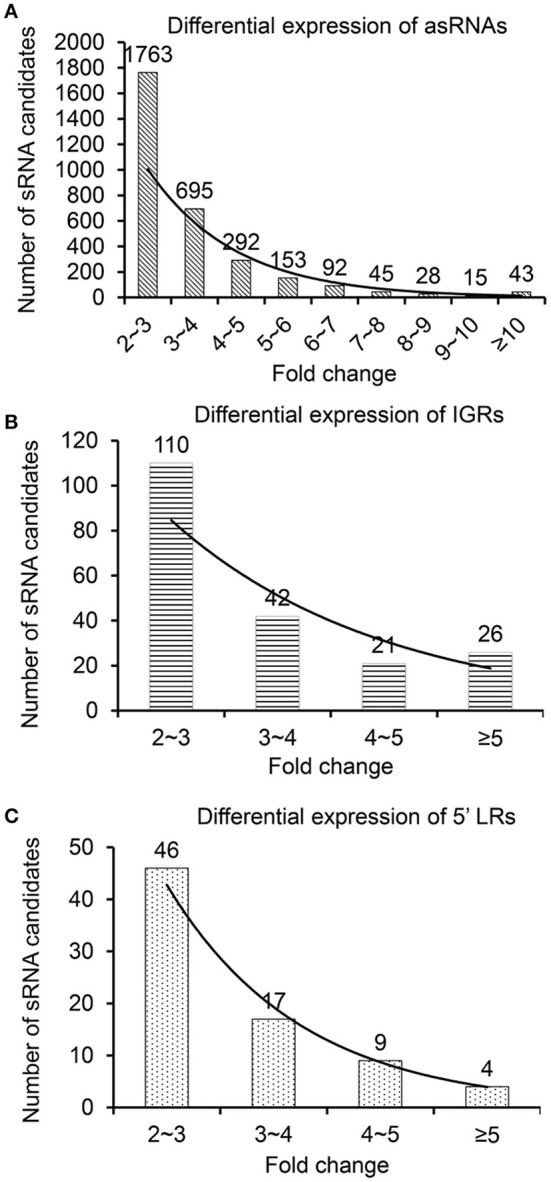
Fold change of differentially expressed sRNAs under NL and HL conditions. Up/down-regulated sRNAs of (A) asRNAs, (B) IGRs, and (C) 5′ LRs in the NL and HL libraries.